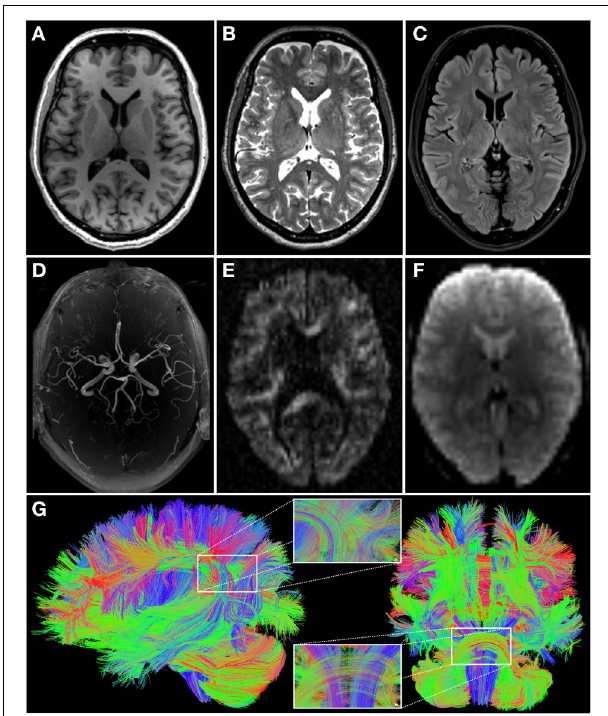
FIGURE 2 | Images illustrating the different modalities of magnetic resonance imaging data acquired in 1000BRAINS (cf. Table 1). (A) T1-weighted; (B) T2-weighted; (C) fluid attenuated inversion recovery (FLAIR); (D) axial maximum intensity projection (MIP) of time-of-flight angiography; (E) high angular resolution diffusion imaging (HARDI, one out of 120 diffusion weighted images); (F) functional and resting-state echo-planar image (EPI). (G) Additionally, exemplary reconstruction of whole brain fiber architecture from HARDI data [as depicted in (E) ], using TrackVis software (http://www.trackvis.org), from the lateral (left) and anterior (right) views. Inlays show enlargements of the fiber architecture within the inferior parietal cortex (top) and the pons and brainstem (bottom). Color coding of fiber directions in accordance with common conventions (blue: top—bottom; red: left—right; green: